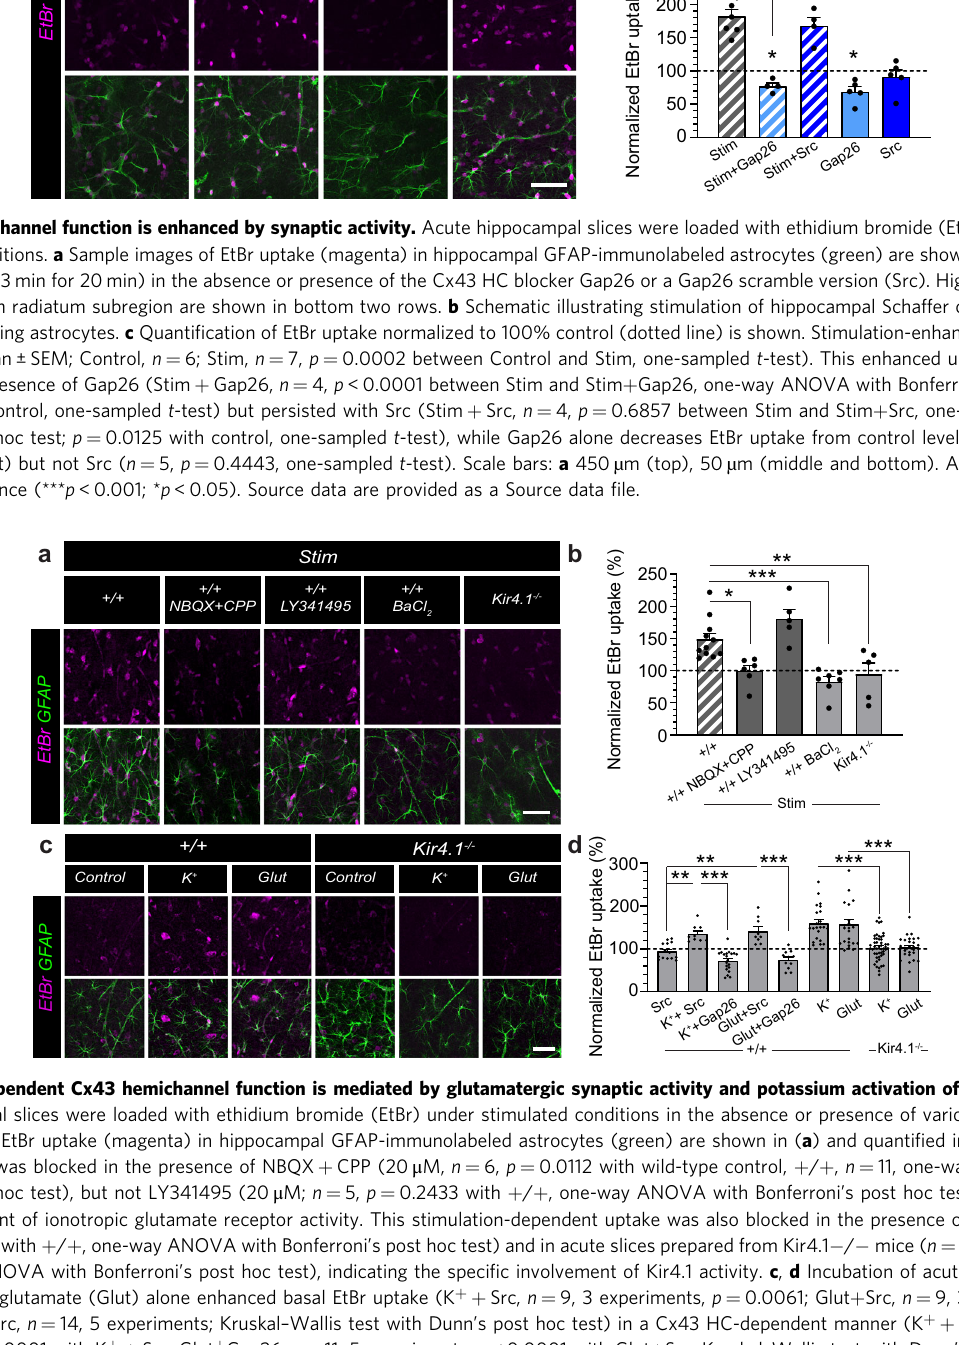
0.0056 with Src, n = 14, 5 experiments; Kruskal – Wallis test with Dunn ’ s post hoc test) in a Cx43 HC-dependent manner (K + + Gap26, n = 20,